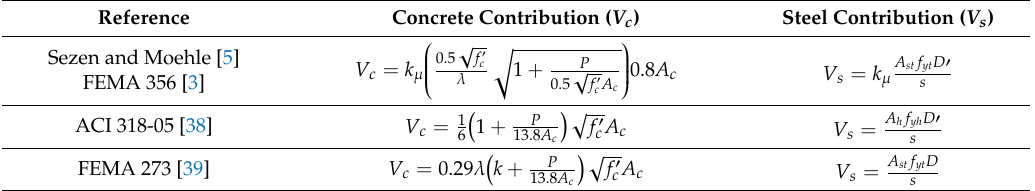
Table 4. Explicit formulas for estimating the shear capacity of RC columns.